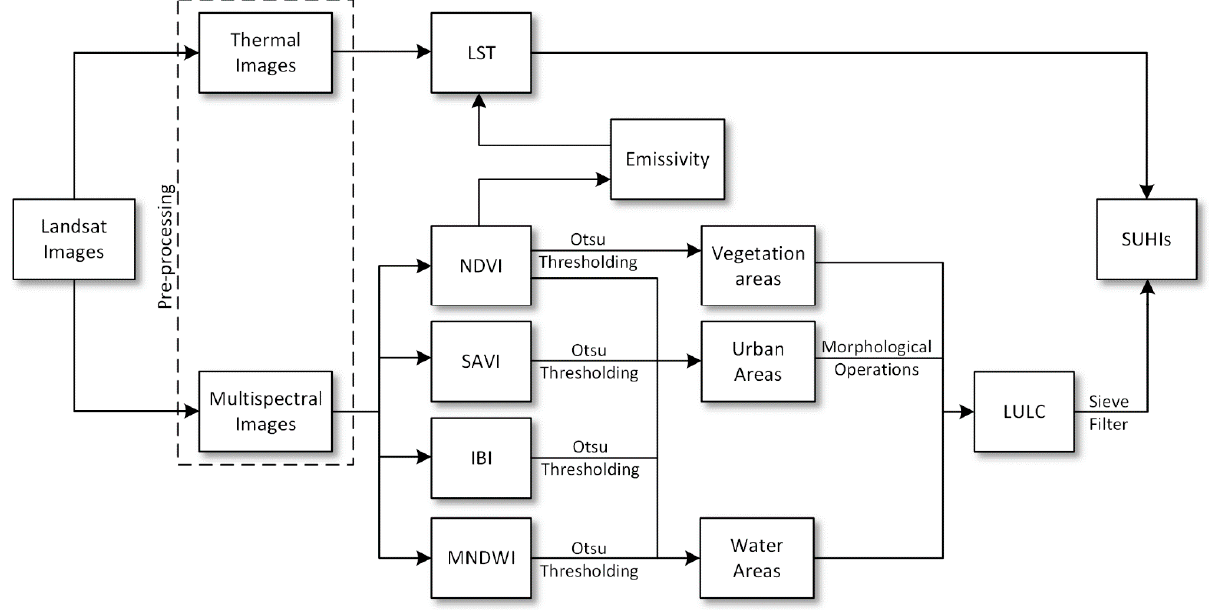
Figure 1. The flowchart of the overall processes.